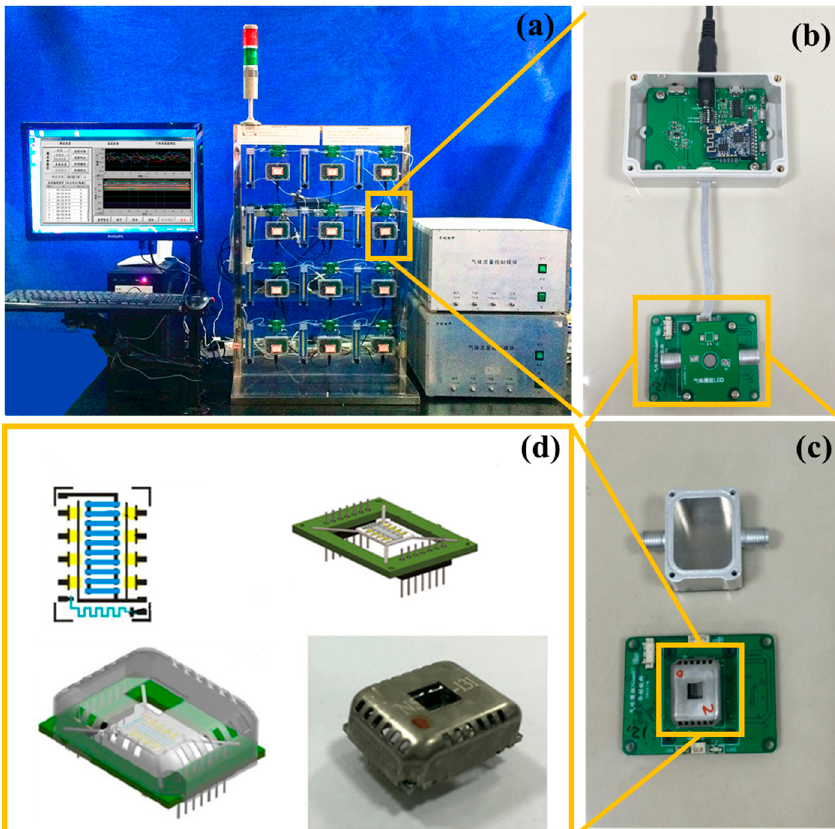
Figure 4. The structure of high-throughput gas sensing unmanned testing platform. ( a ) Testing platform; ( b ) Sensor module; ( c ) Testing chamber and sensor device; ( d ) The structure of the sensor device.